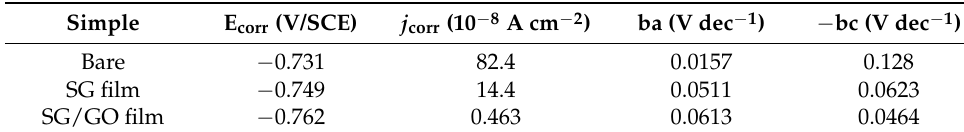
Table 2. Polarization curve-derived parameters of bare Al sample and samples coated with SG film and SG/GO film.